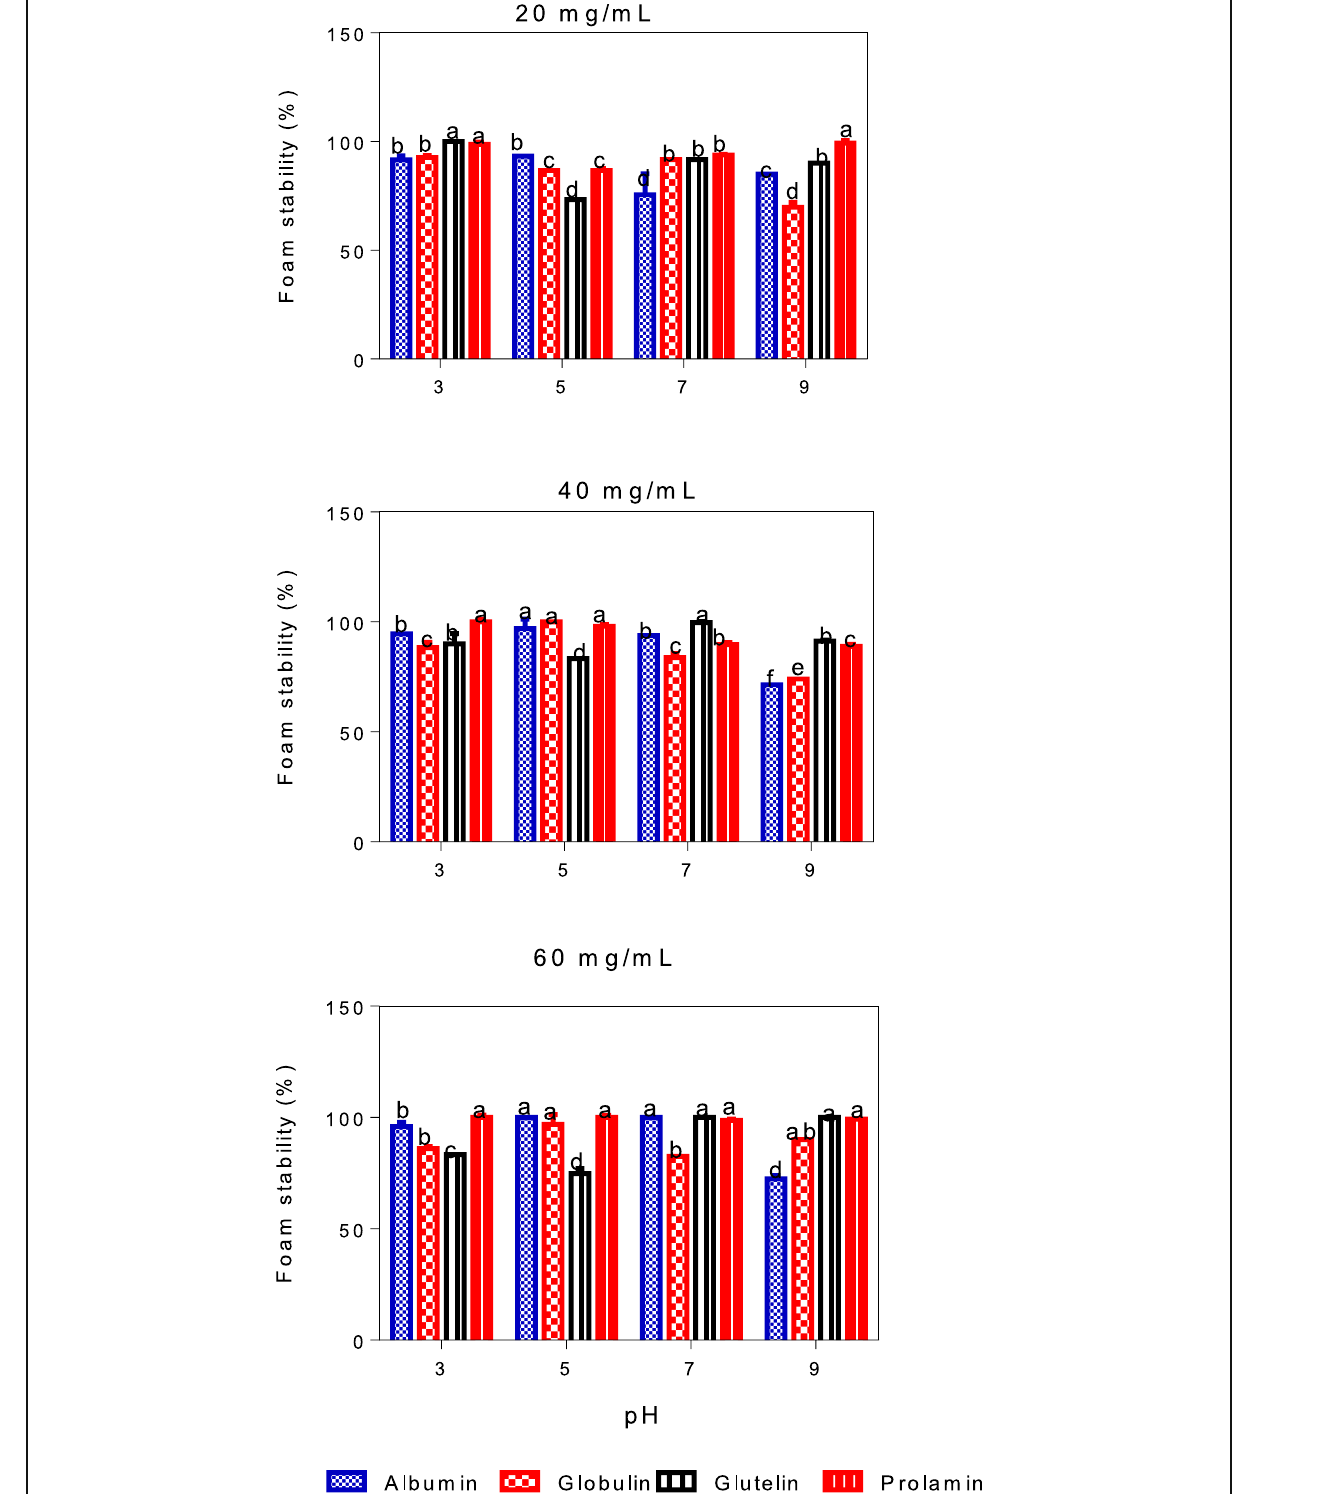
Fig. 6 Effect of pH and protein concentration on foaming stability of sesame protein